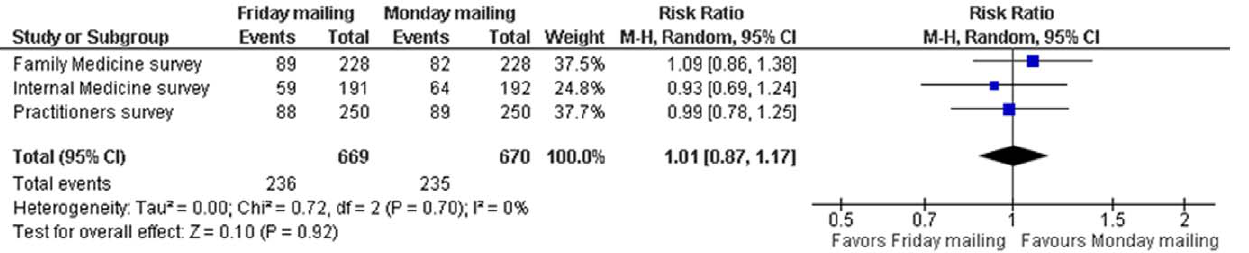
Figure 4. Meta-analysis of response by the time of first reminder comparing Friday vs. Monday mailing.